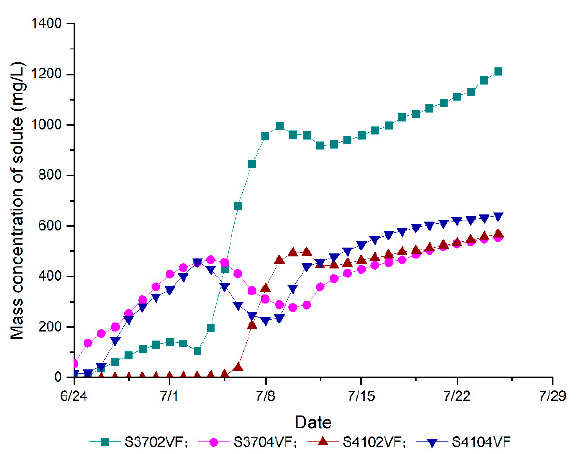
Figure 15. Mass change chart of solute concentration in unit 3902.